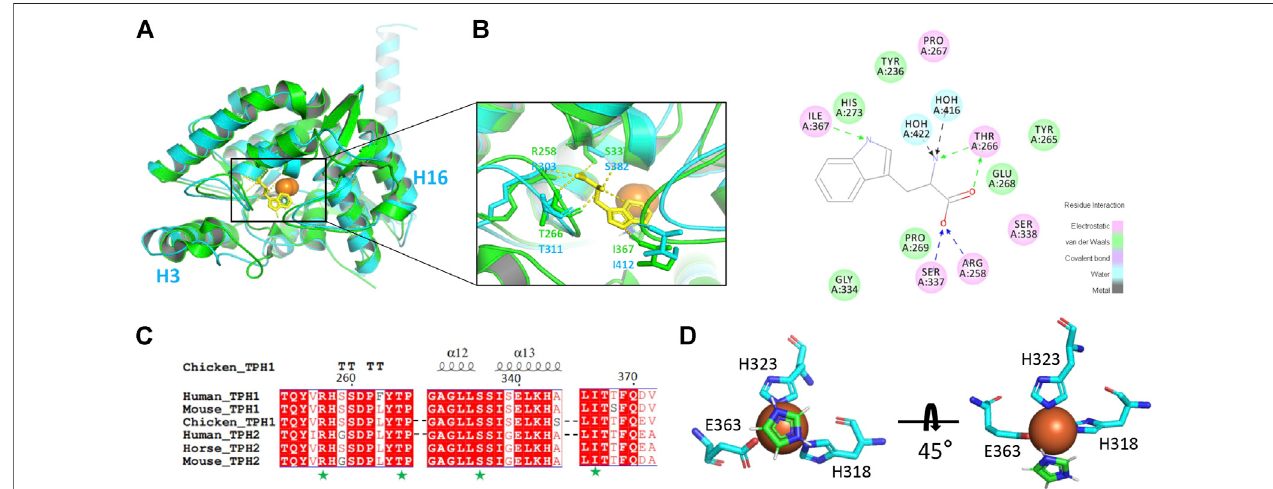
FIGURE3| Cofactorandsubstratebindingsiteanalysis. (A) superimpositionofhumantryptophanhydroxylase2(TPH2)withchickenTPH1andsubstratebinding environment analysis. The human TPH2 is in cyan, and the chicken TPH1 is in chartreuse. The substrate tryptophan is depicted as sticks in yellow. The residues participating in binding are shown as sticks in corresponding colors. (B) schematic graph of all the residues interacting with tryptophan of chicken TPH1 is displayed. Electrostatic interaction is shown in pink, van der Waals interaction is shown in green, and water – ligand interaction is shown in cyan. (C) primary sequence alignmentofhumanTPH2andchickenTPH1producedbyMULTALINandEsprit,inwhichaminoacidswithredbackgroundrepresentidentity.Thesecondarystructure of chicken TPH1 is depicted on the top, and the substrate binding sites are pointed below with a green pentagram. (D) display of Fe 2+ and imidazole binding environment.